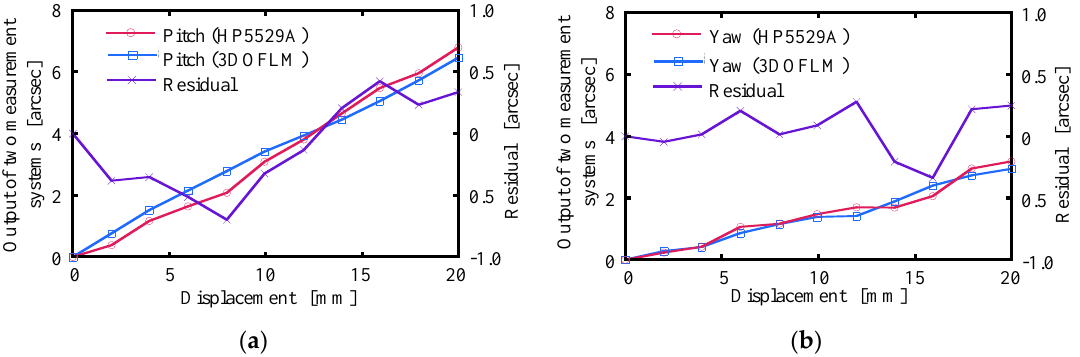
Figure 8. Comparison angle results of measured angular error of the nanopositioning stage by the HP5529A and the 3DOFLM system: ( a ) pitch; ( b ) yaw.